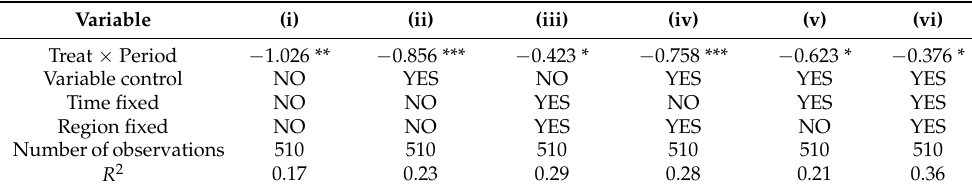
Table 7. DID estimation results of the BLPP effects (industrial sulfur dioxide